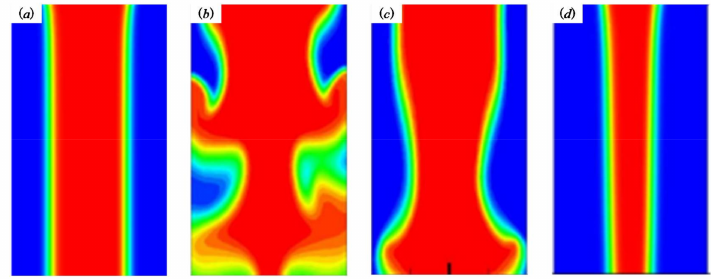
Figure 4. The phenomena occurred in the nozzle. ( a ) L is too short; ( b , c ) L is too short; ( d ) reasonable selection of the lead length L.